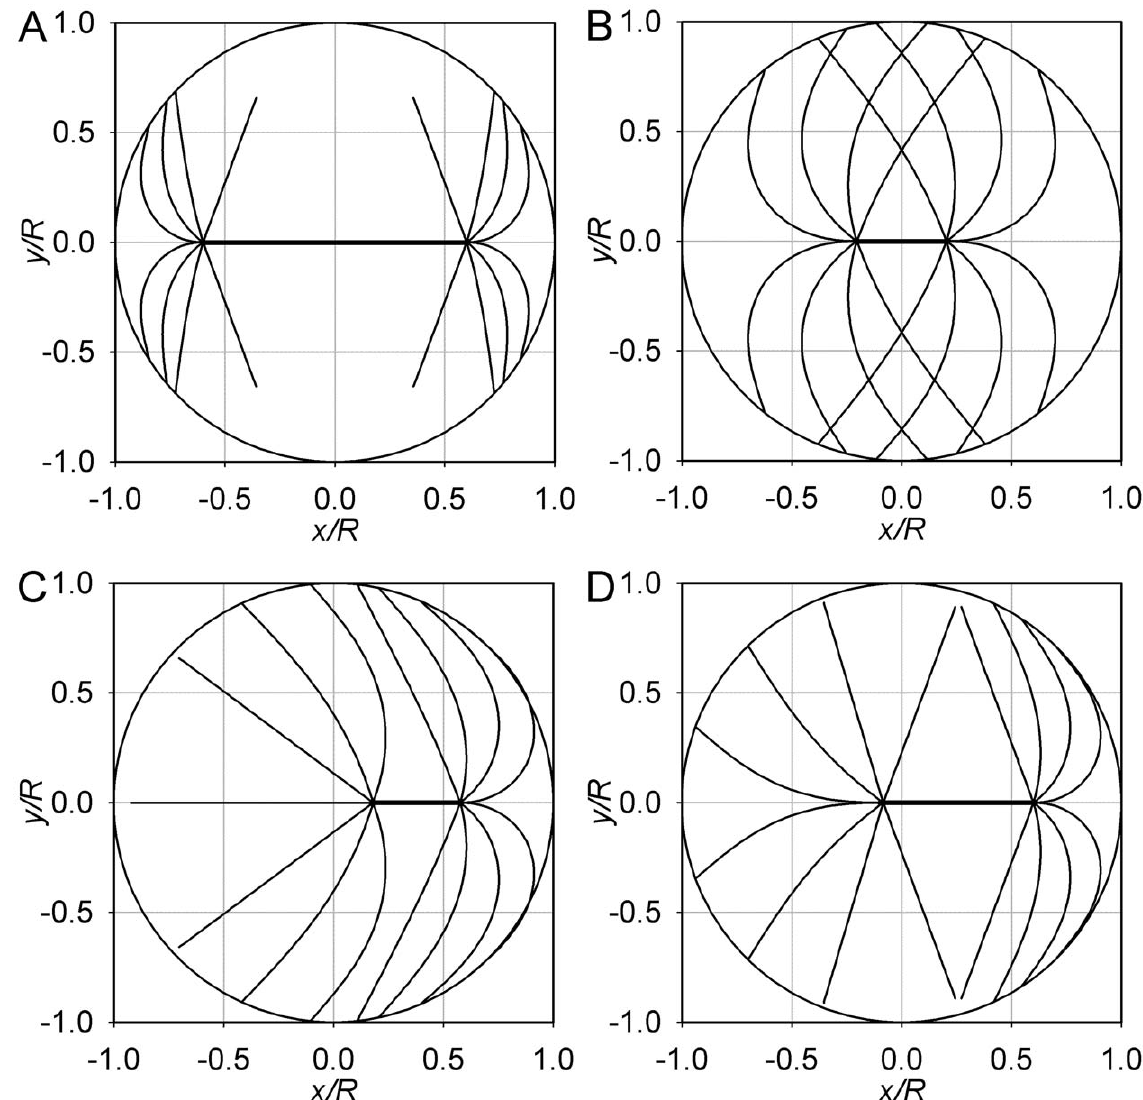
Figure 9. Sample equilibrium conformations. For clarity, only few microtubule forms are plotted. These microtubules lie in the ( x , y ) plane that passes through the spindle axis. Their values of h are sampled uniformly between 0 and h max . The circumference is the section of the cell surface, and the thicker line segment depicts the spindle proper. In all examples, h max =0.6 p . (A) L =0.7 R , S =1.2 R . (B) and (C) represent the alternative conformations that exist with L =1.1 R and S =0.4 R . (D) L =0.95 R , S =0.7 R